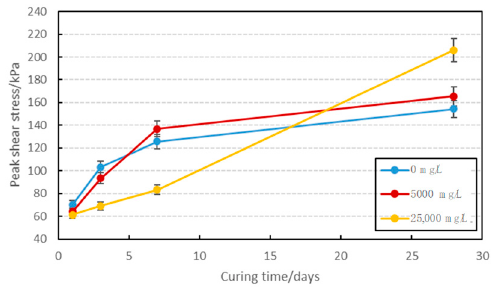
Figure 12. Coupled effects of treatment time and initial sulfate concentration on the evolution of the peak shear stress of the interface (CPB made with 0.3% fibers; normal stress of 100 kPa).